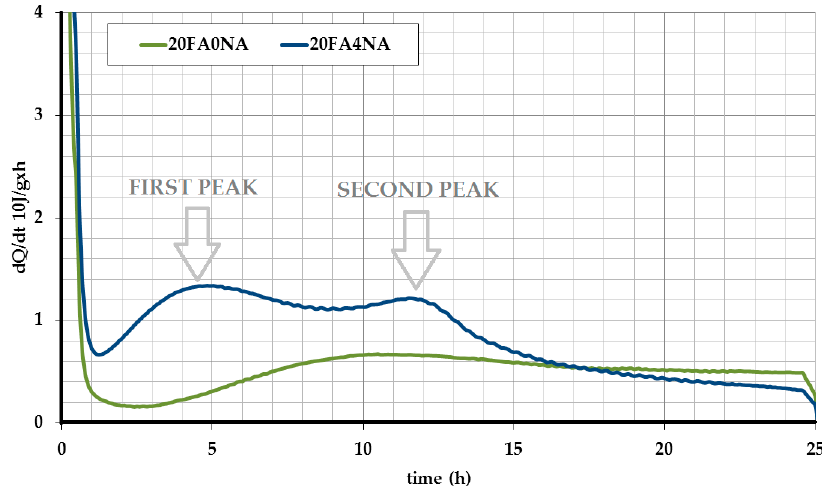
Figure 2. The amount of heat released over time.